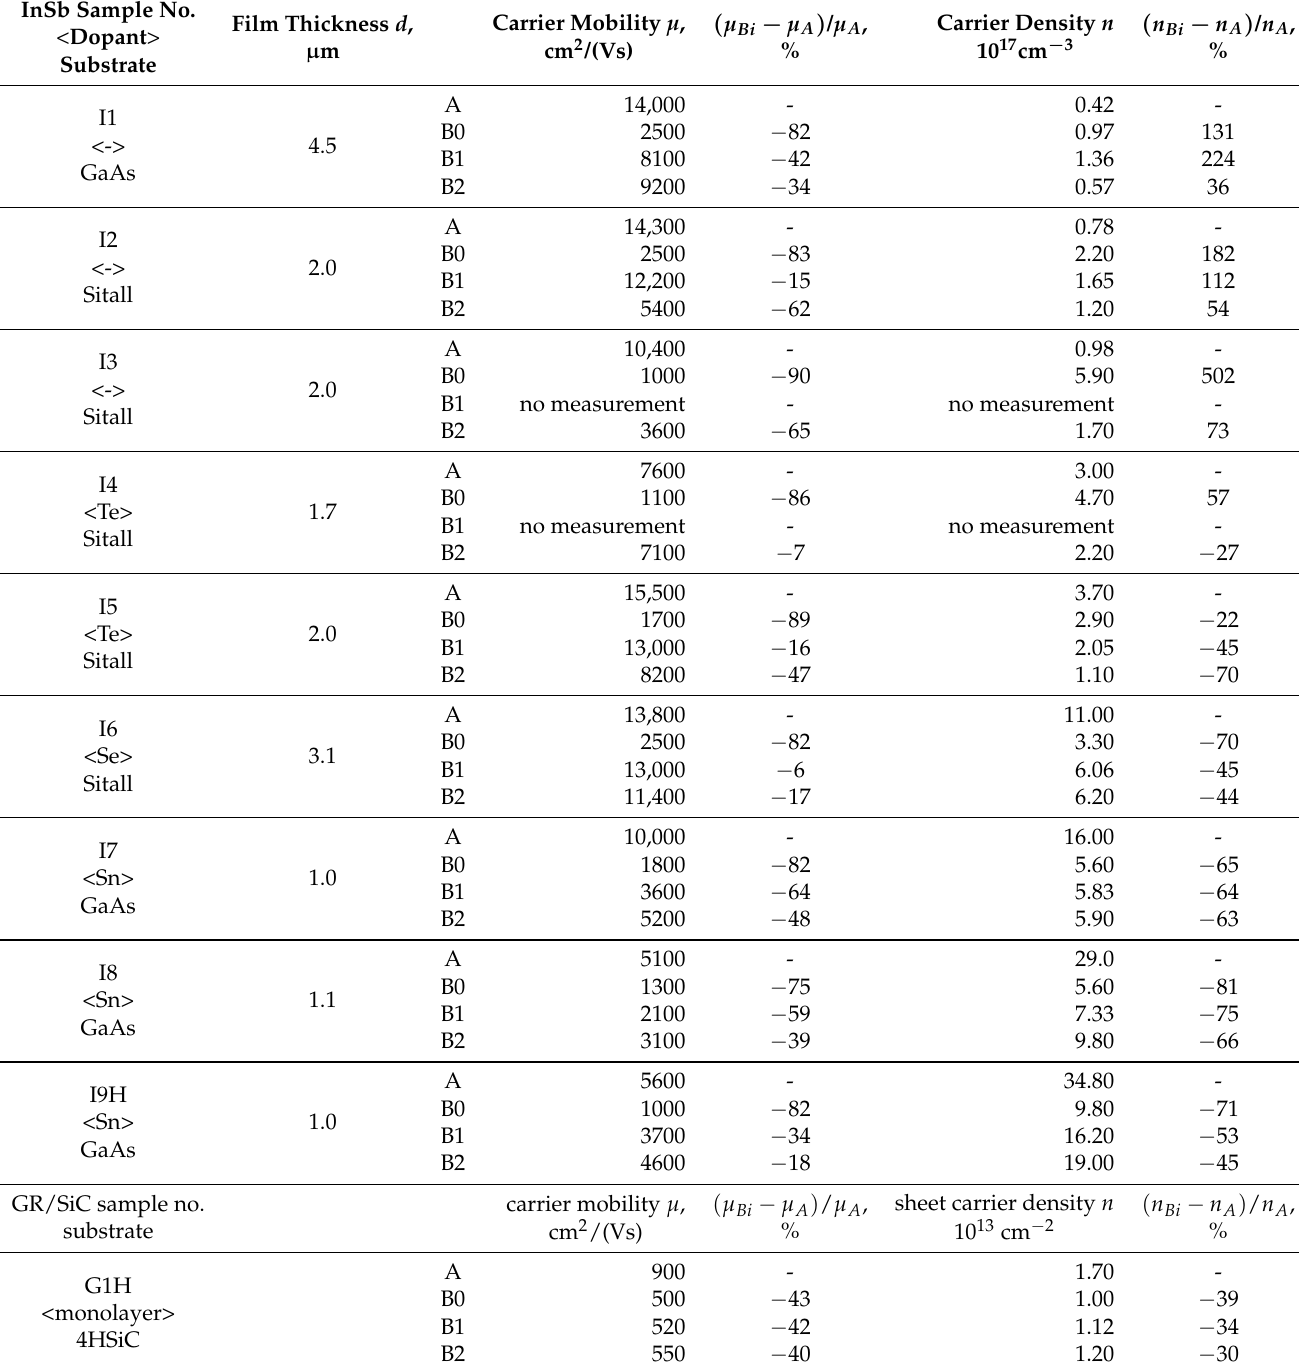
Table 1. Summary of the electrical parameters of the verified structures after the thermal stabilization ( A ), after the irradiation ( B0 ), after the temperature treatment up to 300 ◦ C ( B1 ), and after the temperature treatment up to 350 ◦ C ( B2